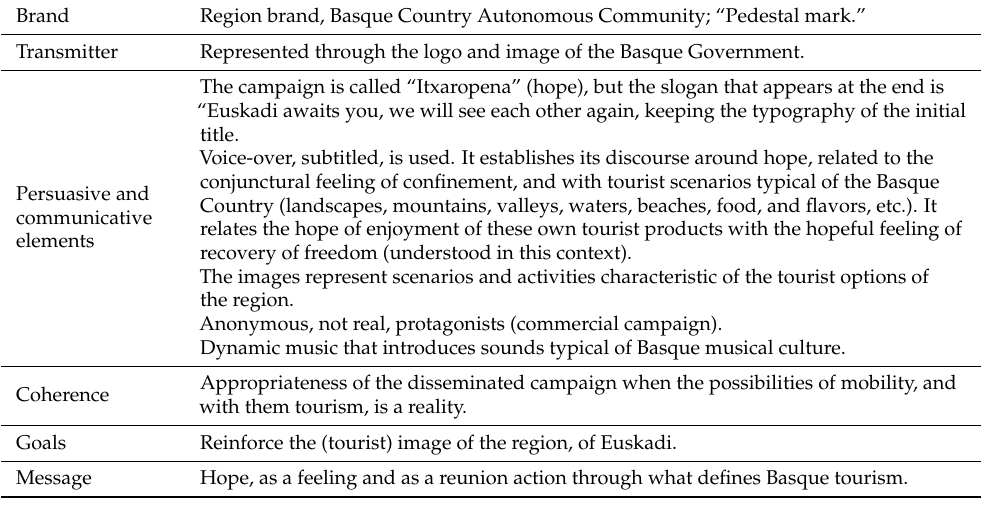
Table 3. “Itxaropena” campaign analysis.